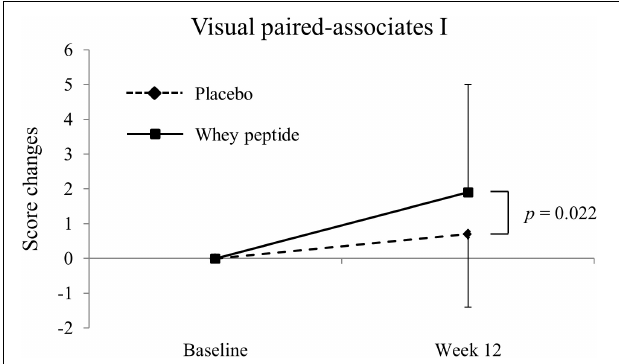
FIGURE 2 | Changes of visual paired-associates I from baseline. The solid line shows the whey peptide group ( n = 51), and the dashed line shows the placebo group ( n = 53). The data are presented as the mean with SD. The p -value shows the results of between-group comparison, performed by unpaired t -test. p < 0.05 was considered as significant difference.